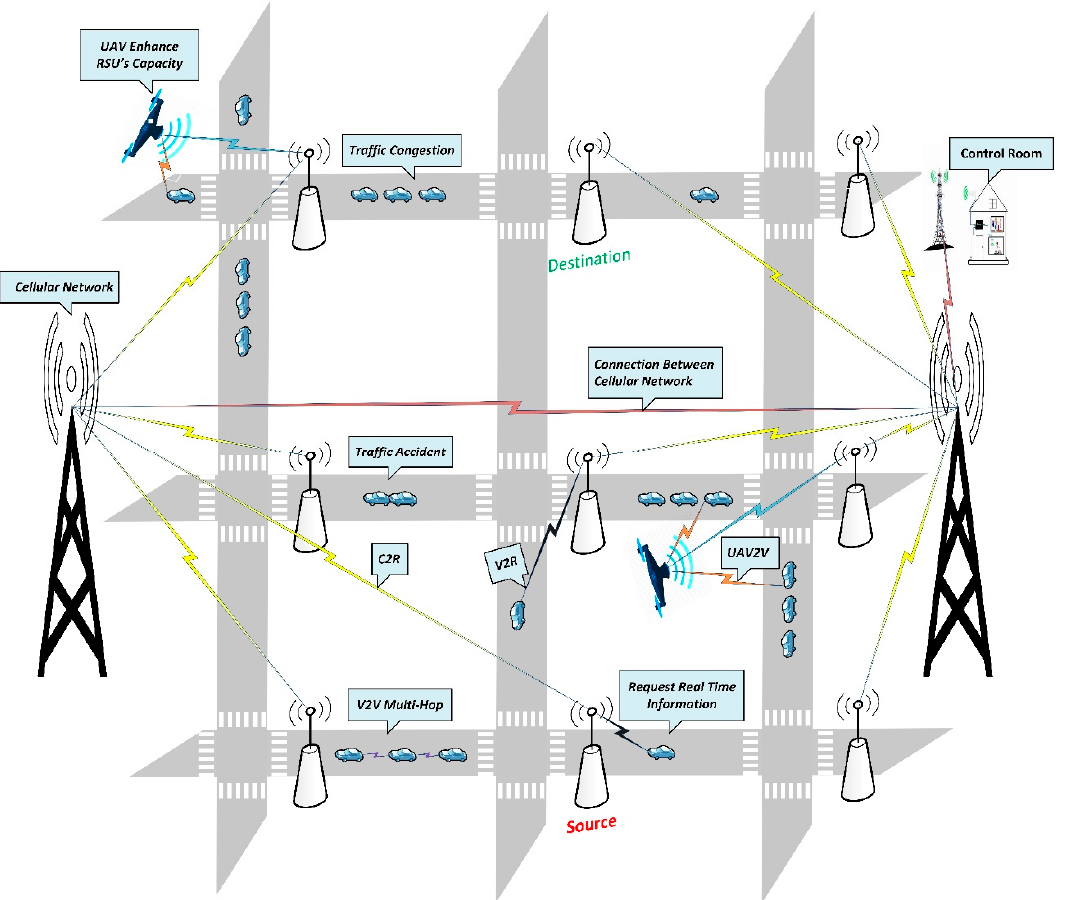
Figure 1. Unmanned aerial vehicle (UAV)-assisted hybrid scheme for urban road safety based on the vehicular ad hoc network (VANET) model.